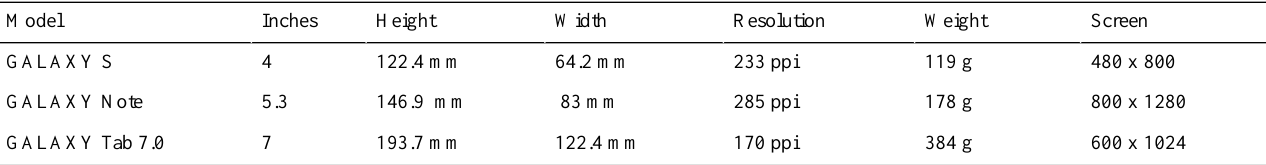
Table 1. Comparison of three different devices.